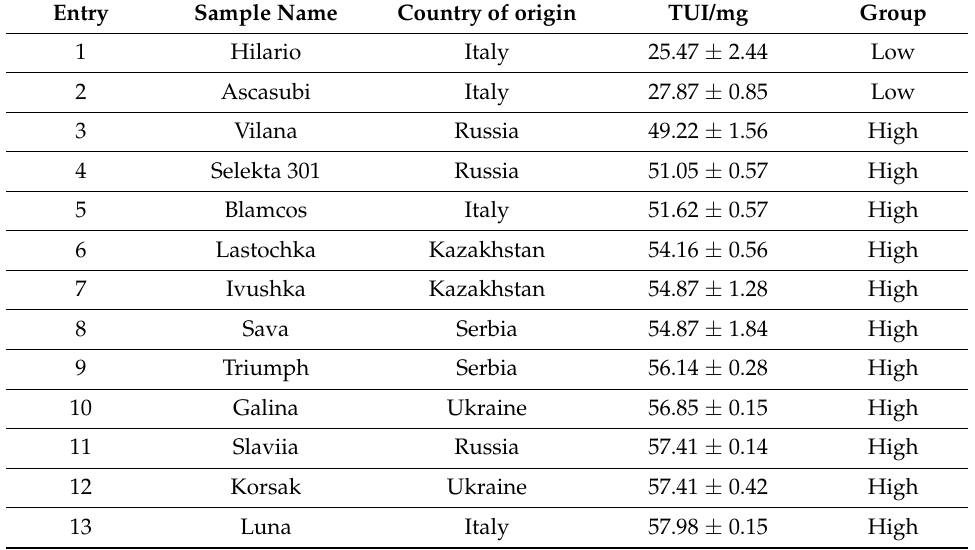
Table 2. Characterization of soybean collection samples according to the activity of the Kunitz trypsin inhibitor. TUI, trypsin units inhibited ± SE ( n =